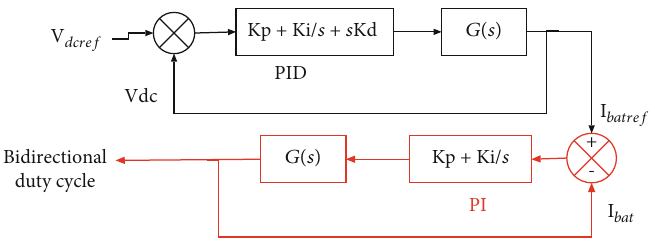
Figure 7: Current and voltage regulation